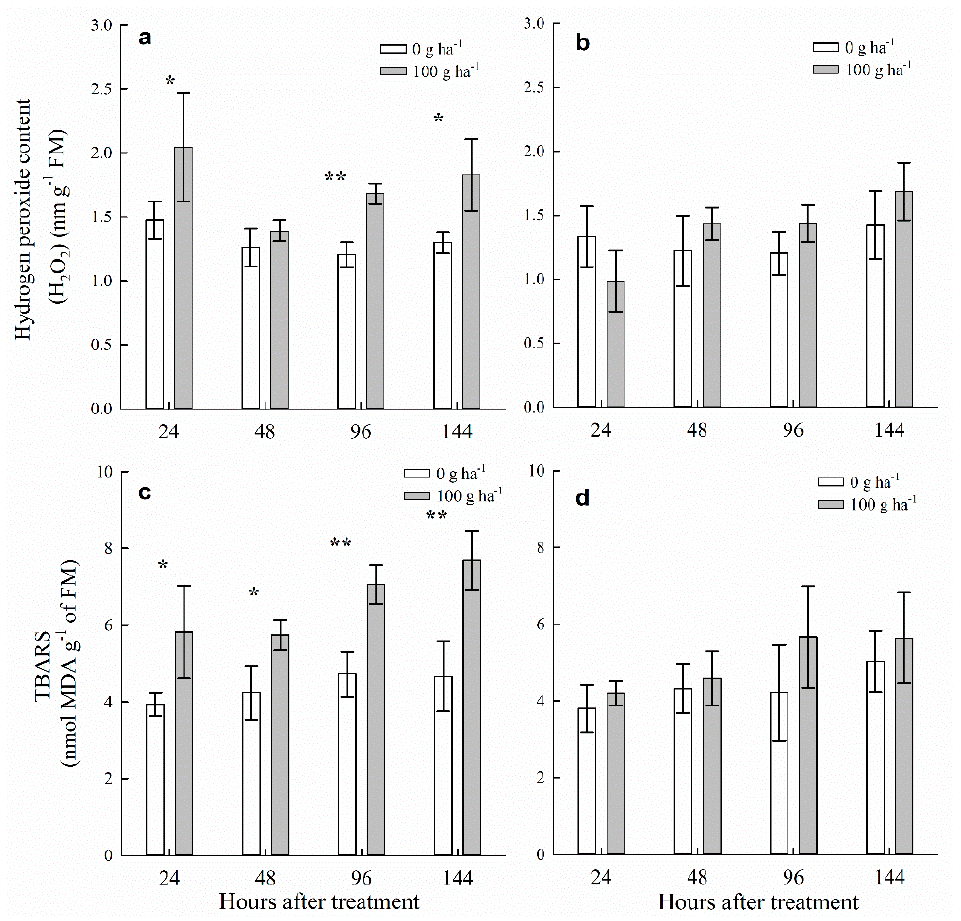
Figure 4. Hydrogen peroxide content (nm g − 1 FM; a , b ) and thiobarbituric acid-reactive substances (nmol MDA g − 1 FM; c , d ) at 24, 48, 96 and 144 h of Eragrostis plana populations CHK ( a , c , no stress) and DRY ( b , d , drought) with and without herbicide hours after application of quizalofop. Error bars represent a 95% confidence interval. * t -test ( α = 0.05); ** t -test ( α = 0.01).